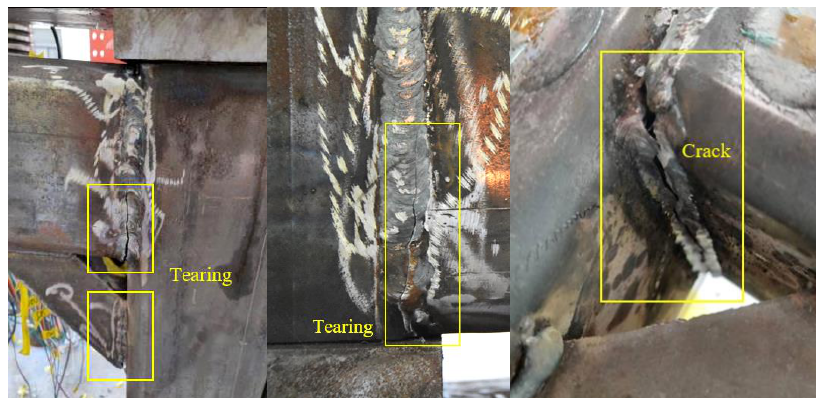
Figure 13. Crack in the welding seam.